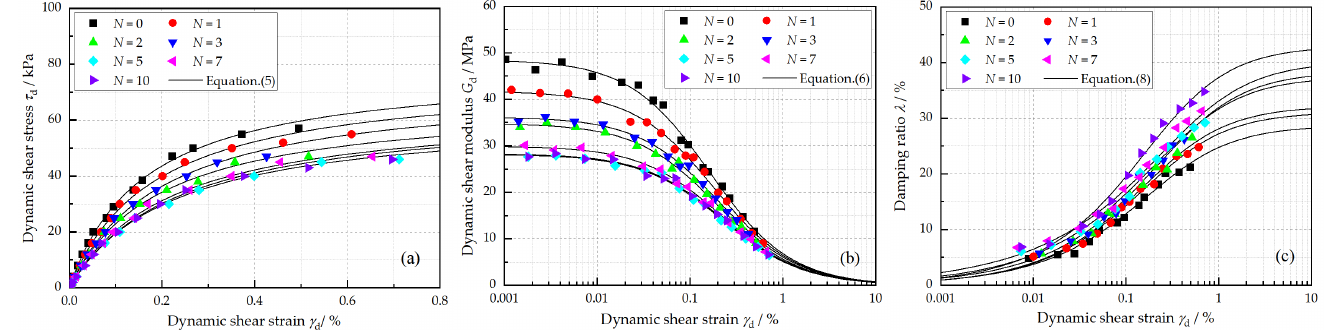
Figure 5. Effects of freeze–thaw cycle on ( a ) backbone curve, ( b ) dynamic shear modulus, and ( c ) damping ratio, under the conditions of C FA = 20%, C PF = 0.5%, w = 18.9%, and σ 3 = 100